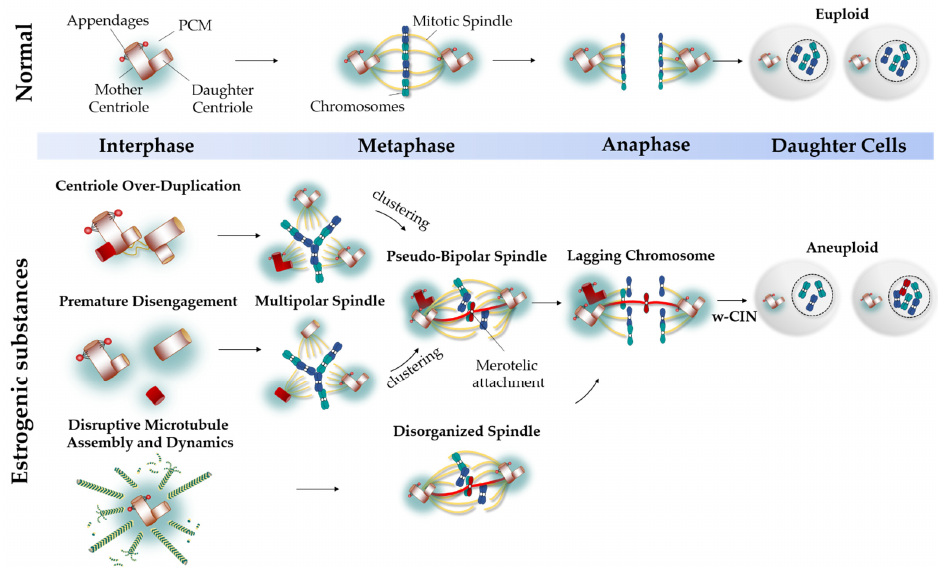
Figure 3. Estrogenic Loss of Centrosome Integrity and Genome Stability. In normal cells, centro- somes duplicate once and only once during the cell cycle, thereby ensuring equal chromosome seg- regation and formation of genetic identical euploid daughter cells. Structural or numerical centro- some aberrations are associated with whole chromosomal instability (w-CIN) and cancer progres- sion. Environmental estrogens are able to alter steps of the centrosome cycle, thereby triggering defects in centrosome integrity. In the presence of estrogenic substances, centriole over-duplicate or disengage prematurely before completing chromosome segregation, forcing the generation of tran- sient multipolar mitotic spindles with merotelic microtubule-kinetochore attachments. To avoid multipolarity-driven lethality, excess centrosomes are clustered into a pseudo-bipolar spindle, how- ever, at the expanse of mitotic fidelity. Through binding to microtubules, estrogenic hormones dis- turb microtubule assembly and spindle dynamics, thereby causing defects in spindle organization that favor faulty kinetochore attachments. Finally, lagging chromosomes evolve at the equatorial plane of metaphase cells that manifest in w-CIN and aneuploidy, which represent hallmarks of hu- man cancer.